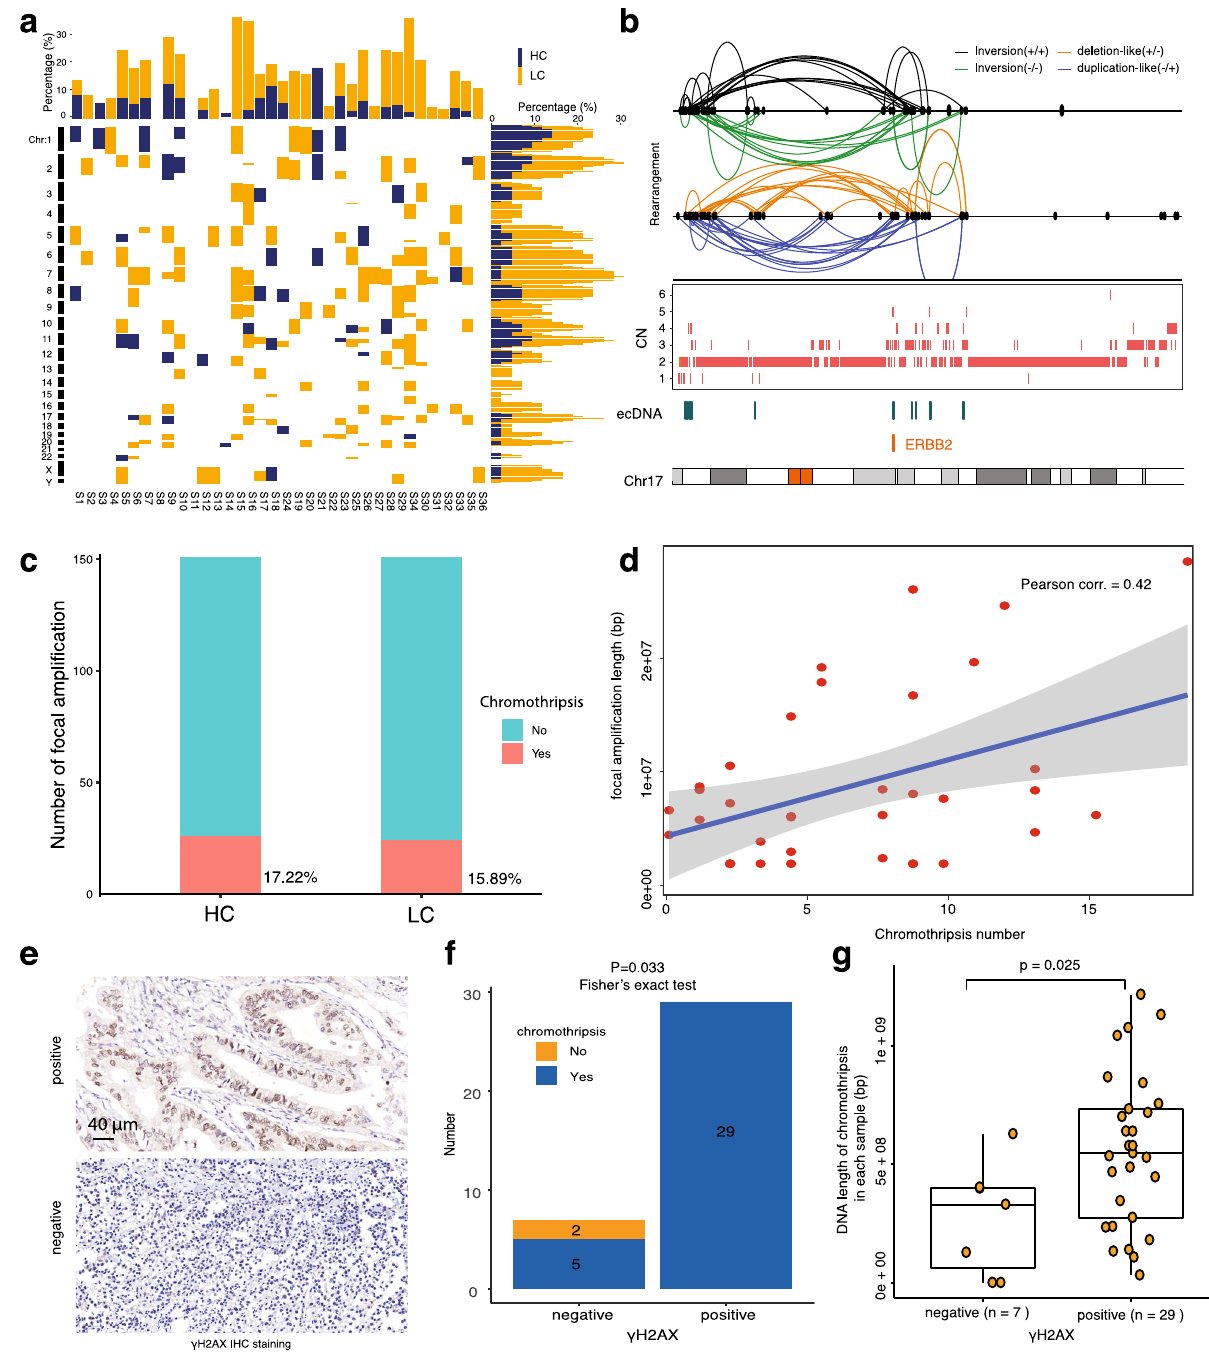
Fig. 3 Focal ampli fi cations and chromothripsis in GCA patients. a Summary of chromothripsis events across the whole genome in our GCA cohort. HC high con fi dence chromothripsis, LC low con fi dence chromothripsis. b ERBB2 focal ampli fi cations in the event of chromothripsis from one GCA patient. The different connection lines on the top represent the potential different formats of chromothripsis events at the ERBB2 gene. CN copy number. c Summary of overlapping frequency between focal ampli fi cations and chromothripsis in the GCA cohort. HC high con fi dence chromothripsis, LC low con fi dence chromothripsis. d The correlation between total length of focal ampli fi cations and the frequency of chromothripsis in GCA patients, where each dot represents one sample. e Representative images of γ H2AX immunohistochemistry (IHC) staining in our GCA cohort. f Presence and absence of chromothripsis in γ H2AX-positive and γ H2AX-negative groups of GCA patients. The numbers on the bars are patient numbers. Two-sided Fisher exact test are performed. g Comparisons of the total length of chromothripsis in γ H2AX-positive and γ H2AX-negative GCA patients, where each dot represents one patient, and the length of chromothripsis is the total length of all chromosomes in each sample. The p -value was calculated using the two-sided Wilcoxon signed-rank test. The box plots show the minima (bottom dot), the maxima (top dot), the median (middle line) and the fi rst and third quartiles (boxes), whereas the whiskers show 1.5× the interquartile range IQR above and below the box. Source data are provided as a Source Data fi le for Fig. 3a – d, f,